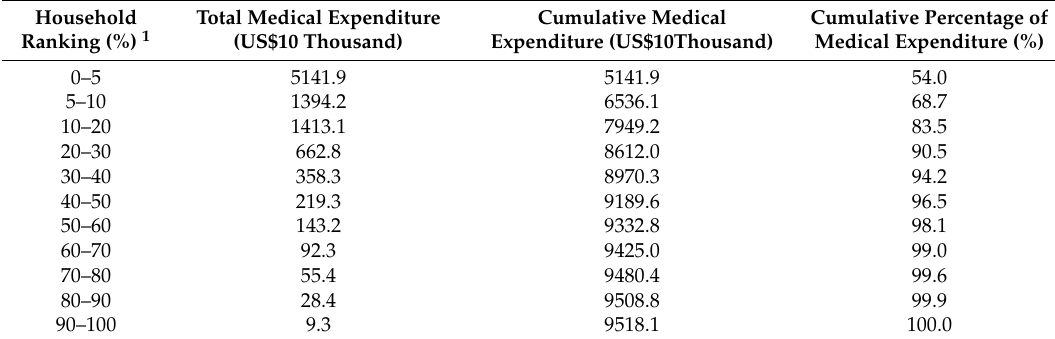
Table 1. Rural household medical expenditure clustering in Macheng in 2014.